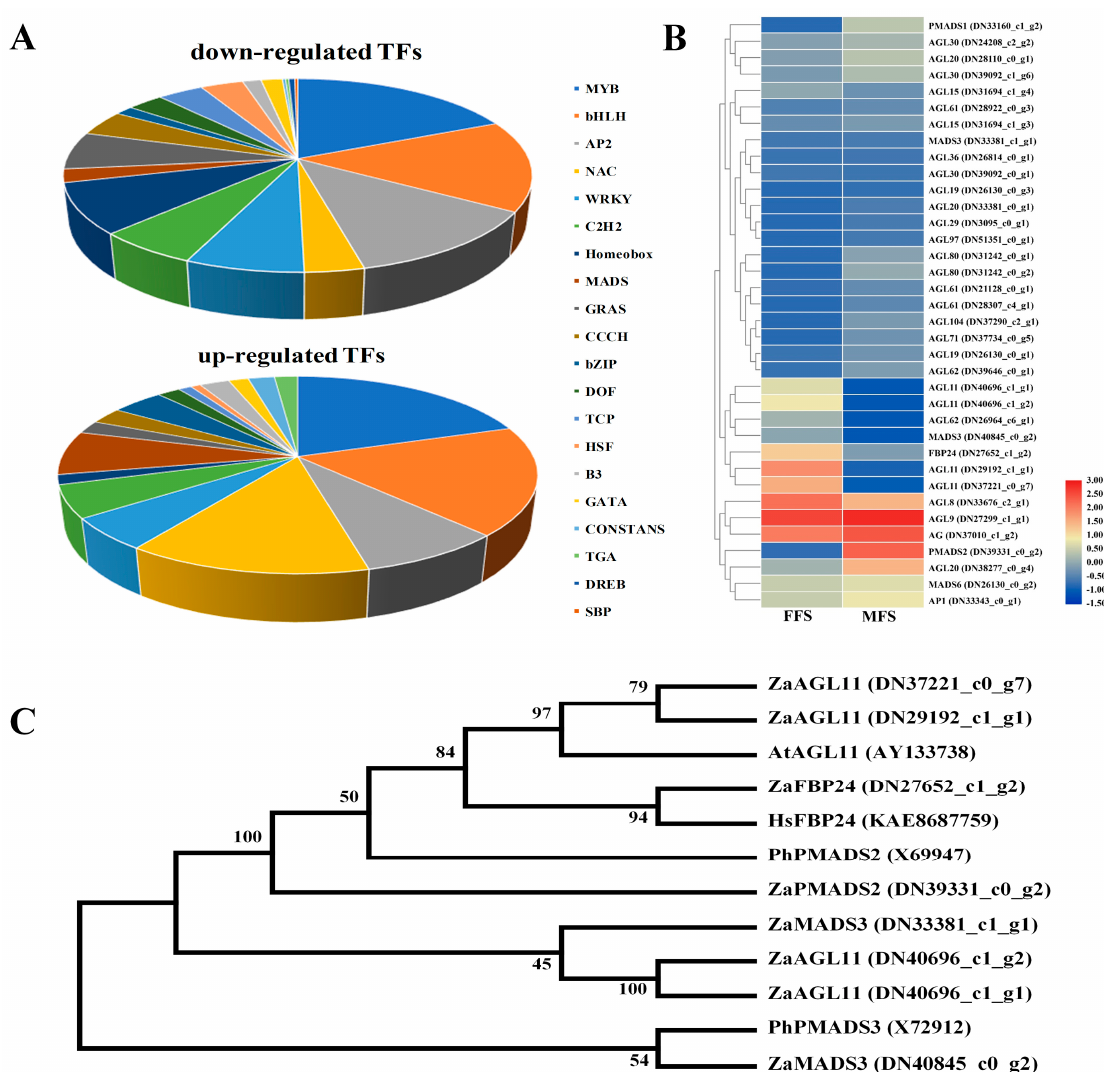
Figure 6. ( A ) Transcription factors associated with flower development in Z. armatum ; ( B ) cluster analysis of MADS-box genes related to flower development of Z. armatum ; ( C ) phylogenetic analysis of MADS-box genes in Z. armatum. ZaAGL11 , ZaFBP24 , ZaPMADS2 , ZaPMADS3 ( Zanthoxylum armatum var. novemfolius ); AtAGL11 ( Arabidopsis thaliana ); HsFBP24 ( Hibiscus syriacus ); PhPMADS2, PhPMADS3 ( Petunia x hybrida ).